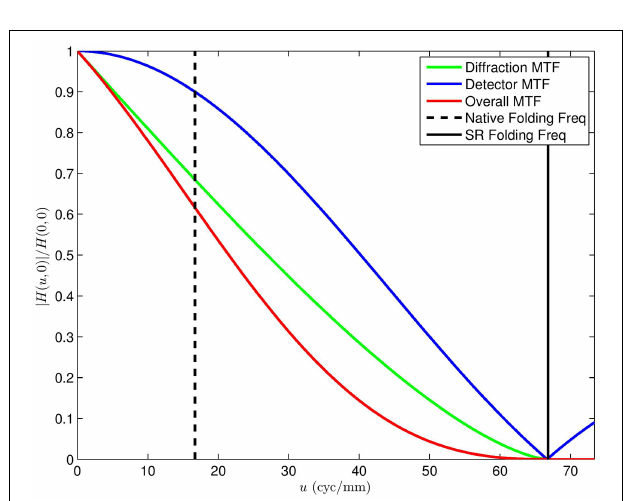
FIGURE 13 | Cross section of the MTF for Figure 12. The native folding frequency for p = 30 μ m is shown along with the L = 4 SR folding frequency. is this: is the loss in overall signal level justified by a favorable detector zero location? To help answer this question, consider the plot in Figure 14 . This shows the relative gain as the detector zero is moved from 1 / p cycles/mm (for a 100% fill factor) to 1 / pQ cycles/mm (where the first detector zero is aligned with the optical cutoff frequency). The red curve on the bottom is for a square detector, and the blue curve on top is for a circular detector. This shows the reduction in signal as the active area is